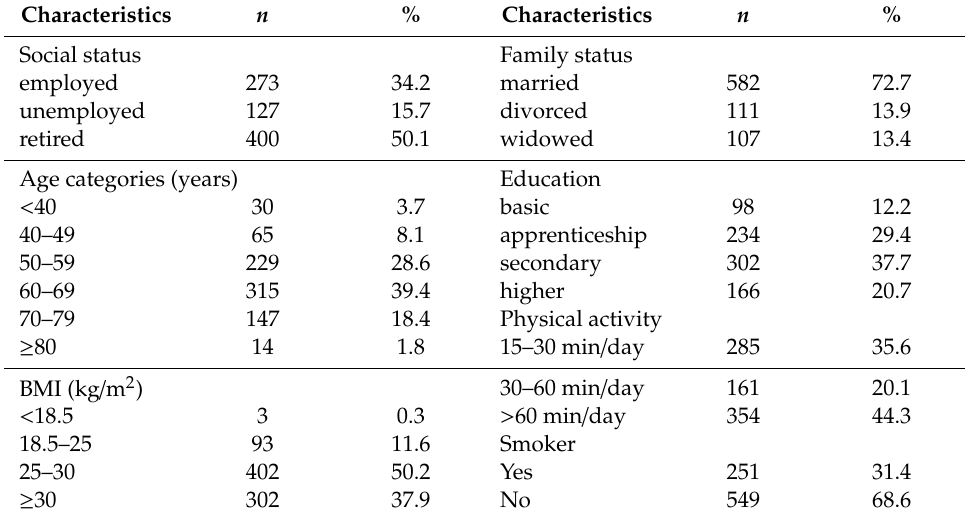
Table 2. Demographic characteristics of study participants ( n = 800).